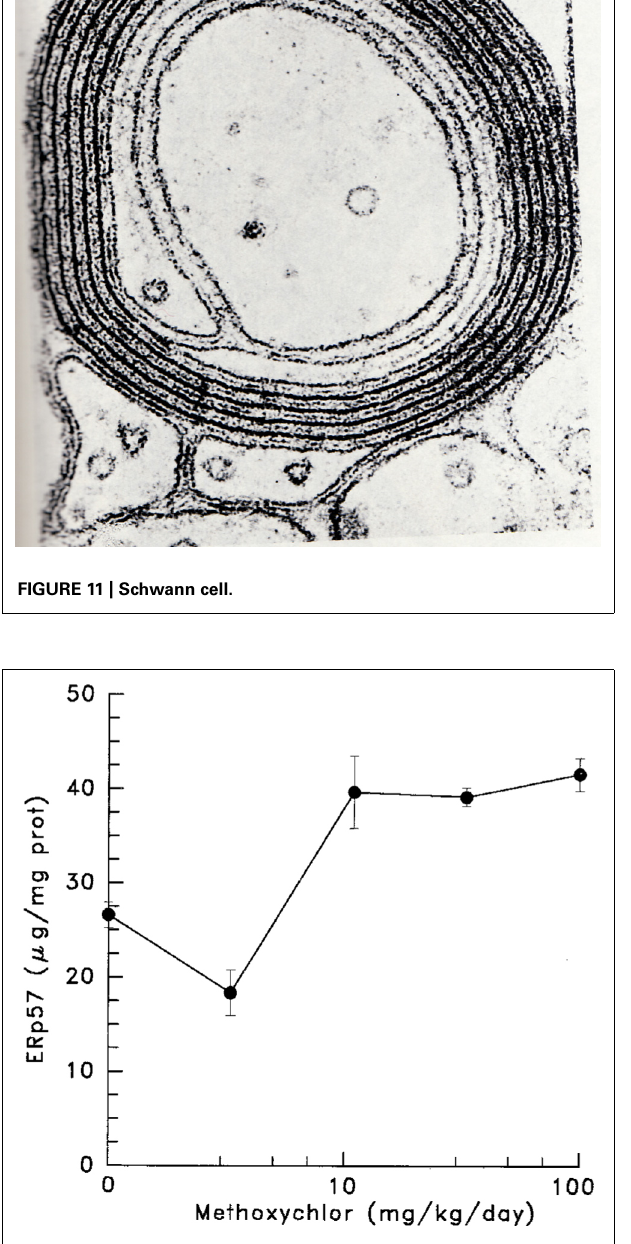
2. The reason that plaque does not form in the young is because A β is normally N -glycosylated and bound to two ER chaperones, ERp57 and calreticulin, which keep it in solution. 3. These components decline with